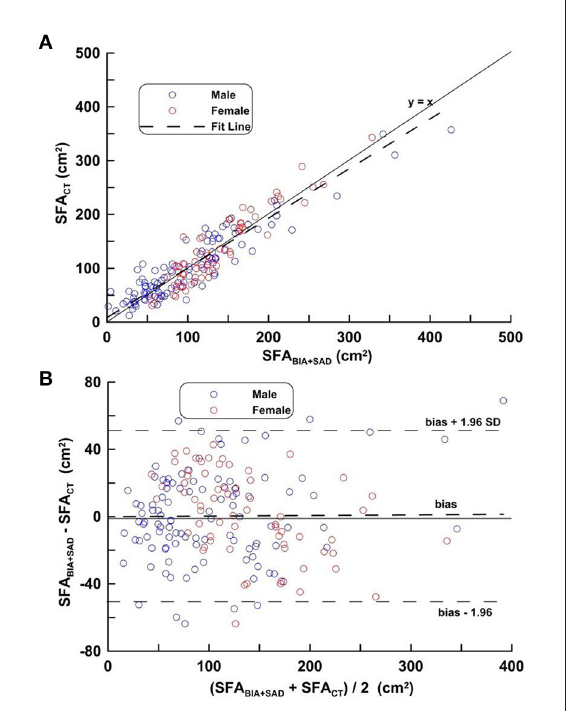
FIGURE2 (A,B) Correlation analysis (top) and difference analysis (bottom) of SFA in the MG on SFA CT , bioimpedance and SAD. The difference (calculated SFA CT -SFA BIA + SAD on Bland-Altman) is the mean of the corresponding measurements of SFA on CT and BIA + SAD ( y = 12.07 − 0.029 x, p = 0.103). Blue circles represent males and red circles represent females.